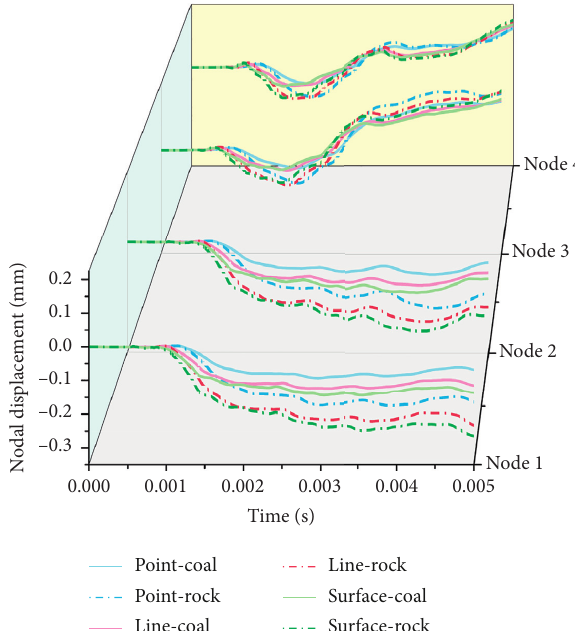
Figure 21: Nodal displacement in the tail beam noncollision contact zone under different contact